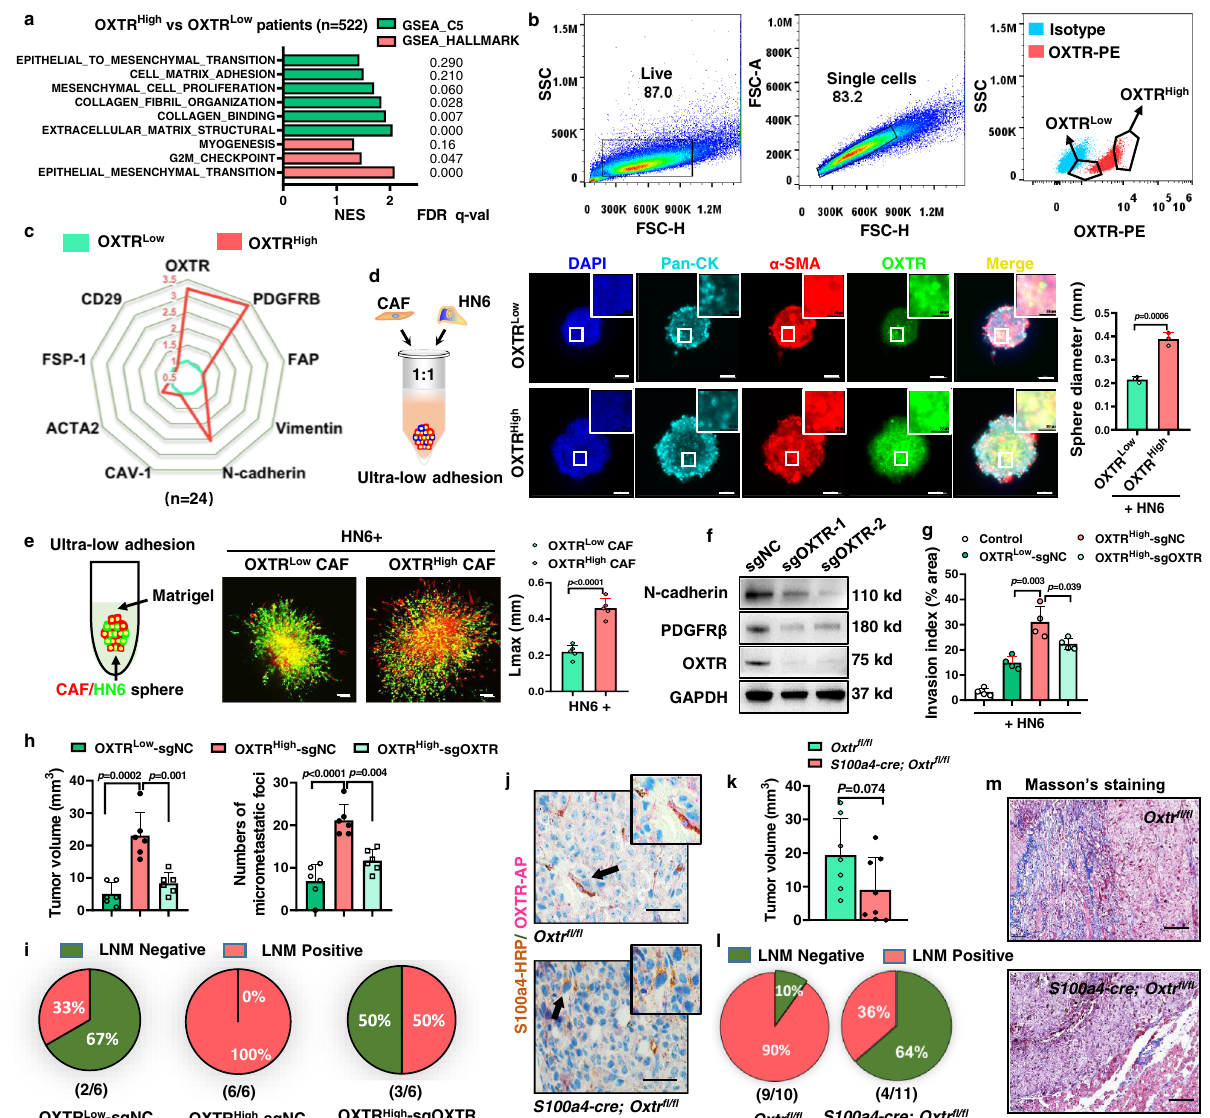
Fig. 4 | Loss of OXTR in CAFs attenuates pro-invasion function in a ligand- independent manner. a Top ECM-remodeling pathways hits from a GSEA analysis of OXTR High versus OXTR Low HNSCC patient samples, n =522, using compilations H andC5(MSigDB). b FlowcytometrygatingusedtosortOXTR High andOXTR Low CAFs from CAF WPOI4-5 cell lines, and c estimated qPCR expression patterns of eight fi broblast markers. OXTR Low CAF was used as normalized control (Green wire, value=1).TheredwireisOXTR High CAF,scaleofthecoordinateaxisisalsolabeledin red. d Setup of co-culture of HN6 with OXTR low or OXTR high CAFs to form hetero- typic spheroids and graphical representation of organoid diameter. Pan-CK-blue — tumorcells, α -SMA-red — CAFs,green — OXTR. n =3/group, P =two-tailed t test.Scale bars,50 μ mor100 μ m. e SetupofheterotypicorganoidformationfromCAFs(red) or mixed with HN6 (green) cultured in Matrigel gels mixed with collagen I. The matrix invasion of CAF/HN6 heterotypic organoid was determined estimating the maximal distance of invasion from the spheroid border (Lmax). n =5/group, P =